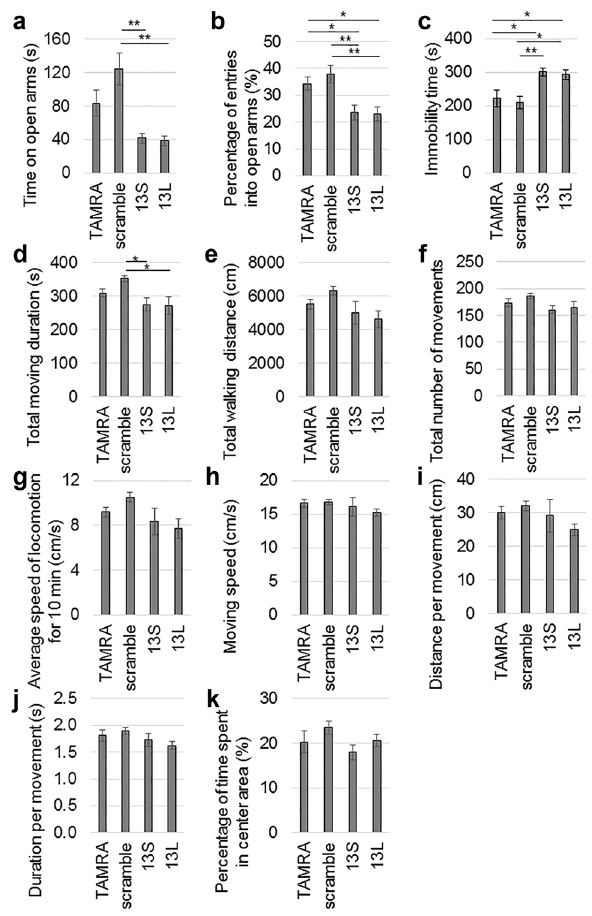
Figure 6. Altered performances of elevated plus maze and forced swimming tests by 13S and 13L. ( a , b ) Elevated plus maze test. Time on open arms ( a ) and percentage of the number of entries into the open arms out of the number of entries into all 4 arms ( b ) were measured in mice given TAMRA, scrambled serine, 13S or 13L (n = 18 each). ( c ) Immobility time during forced swim test were measured in mice given TAMRA, scrambled serine, 13S or 13L (n = 18 each). ( d – k ) Open field test. Spontaneous motor activity of the mice were evaluated in an open field for 10 min. The total moving duration ( d ), total walking distance ( e ), total number of movements ( f ), average speed of locomotion for 10 min ( g ), moving speed ( h ), distance per movement ( i ), duration per movement ( j ) and percentage of time spent in the center area ( k ) were measured in mice in which TAMRA (n = 9), scrambled serine (n = 10), 13S (n = 10) or 13L (n = 10) was injected. Error bars represent SE. ANOVA, * p < 0.05, ** p <